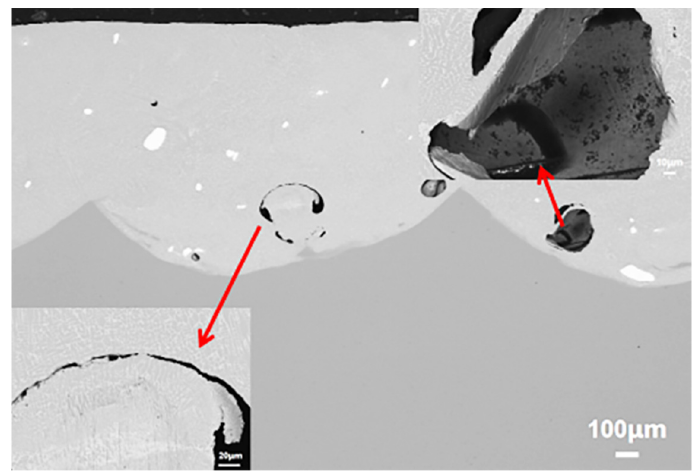
Figure 8. The cracks and holes in FESEM image of CoCrFeNi HEACC (40 wt.% WC).